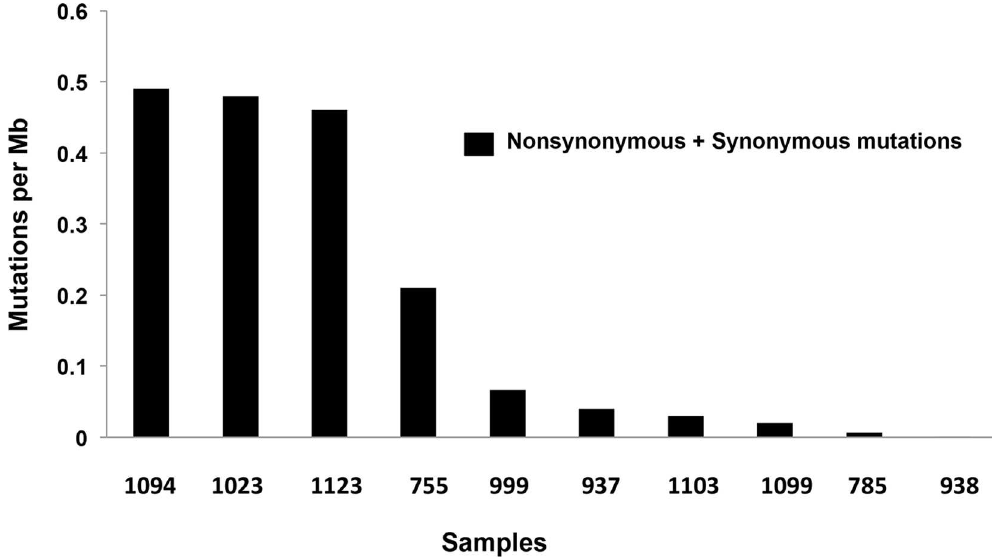
Fig 1. Frequency of somatic mutations in each of the 10 cases. The frequency of all the mutations (synonymous and nonsynonymous) per Mb of genome is depicted. Each bar represents an individual tumour sample and the numberbelow the bar is the designatedlaboratory number of each